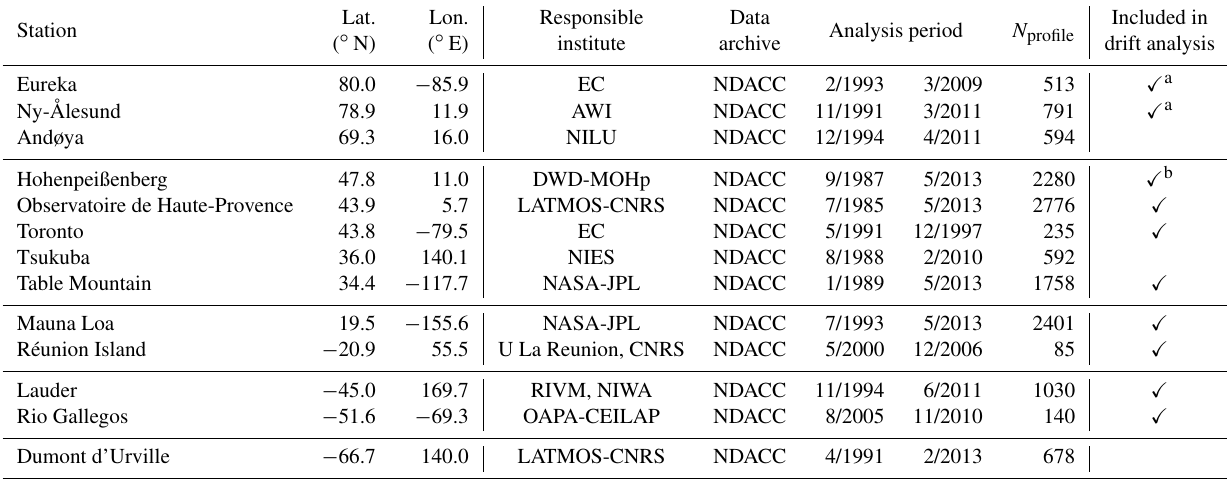
Lat. Lon. Responsible Data